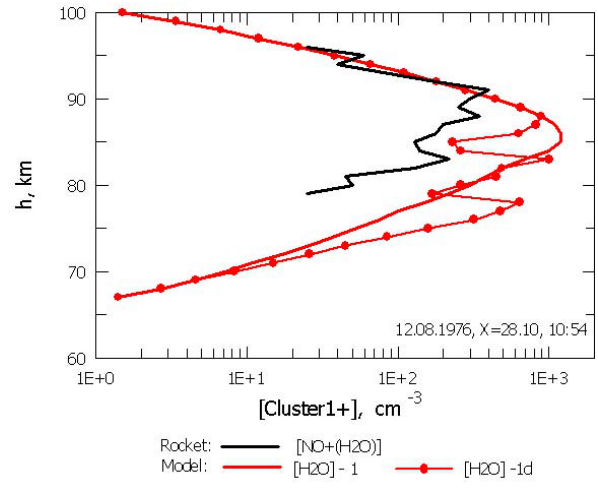
Fig. 8. Electron number density profile measured by Kopp and Her- rmann (1984) for 12 August 1976 at 10:54LT, with a solar zenith angle of 28.10 ◦ (black line) and calculated for the H 2 O-1, H 2 O-1c and H 2 O-1d profiles presented in Fig. 11.